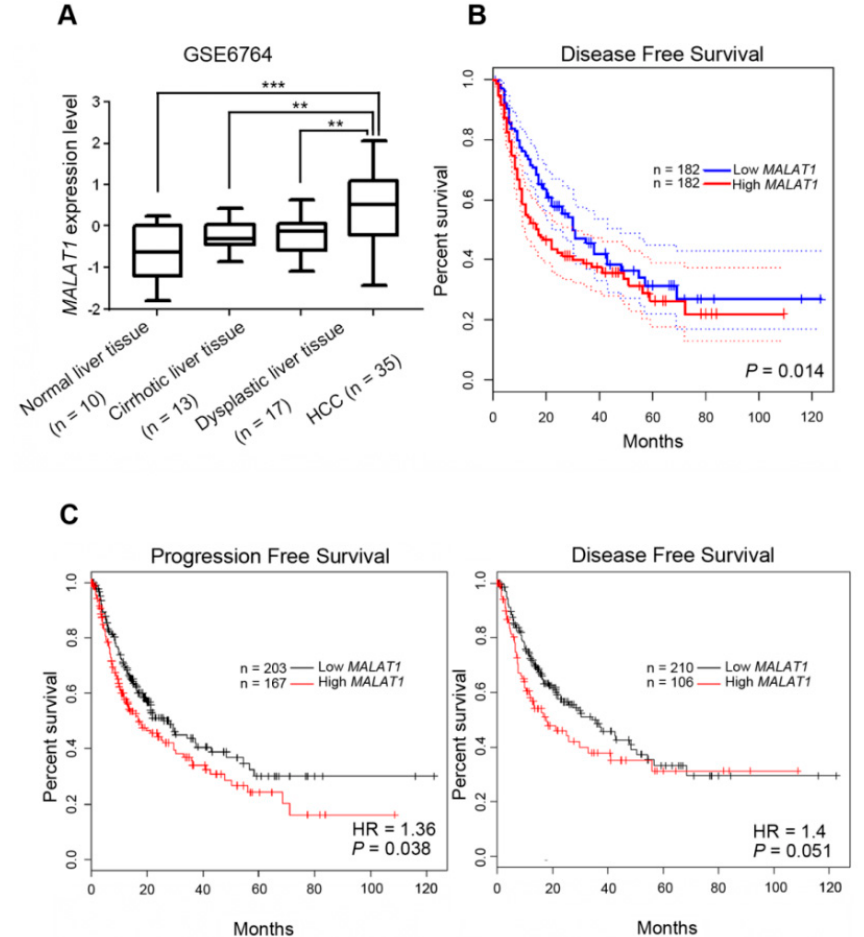
Figure 1. Clinical relevance of MALAT1 expression in the development and prognosis of hepatocellular carcinoma (HCC). ( A ) MALAT1 gene expression levels in normal liver, cirrhotic liver, dysplastic liver, and HCC tissues compared according to data from GEO datasets (GSE6764). ( B , C ) Kaplan–Meier plots of disease-free and progression-free survival of HCC patients stratified by MALAT1 expression, which were analyzed by GEPIA ( B ) and KM plotter ( C ), respectively. A log-rank test was used to examine between-group differences. HR, hazard ratio.